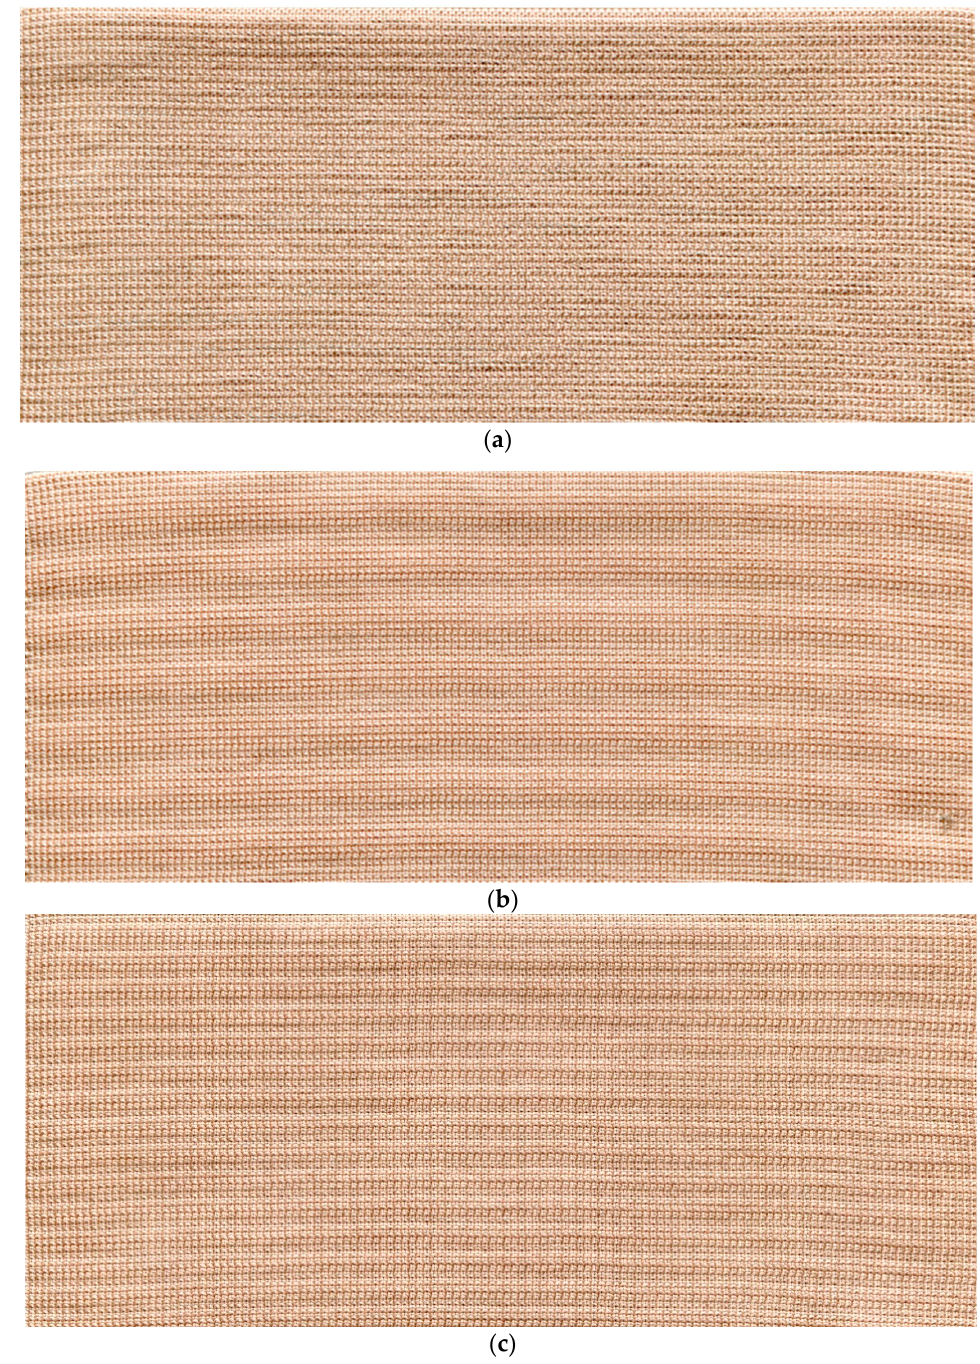
Figure 3. Images of conductive fabrics: ( a ) EFL1 and EFH1; ( b ) EFL2 and EFH2; ( c ) EFL3 and EFH3. Table 2. Main characteristics of designed samples.